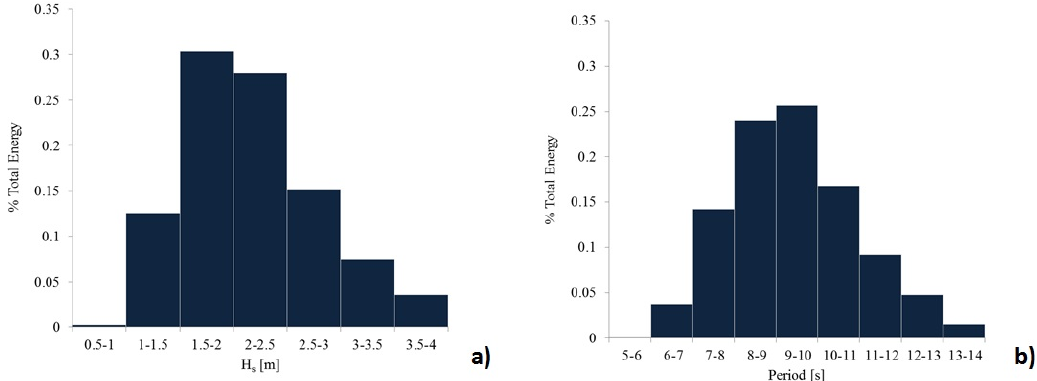
Figure 5. ( a ) Percentage of total wave energy vs. significant wave height at grid point P16; ( b ) Percentage of total wave energy vs. peak wave period at grid point P16.